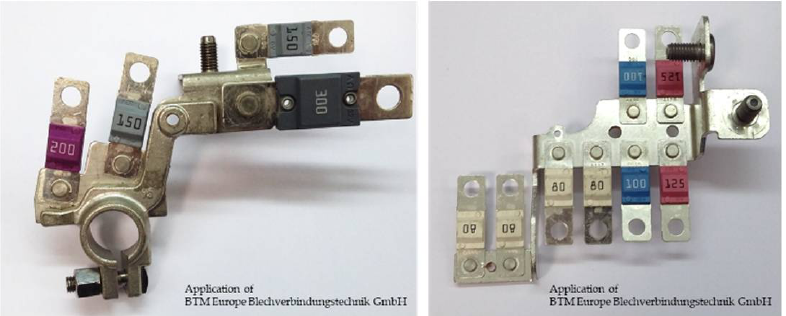
Figure 1. Clinched joints and functional elements in electrical applications.